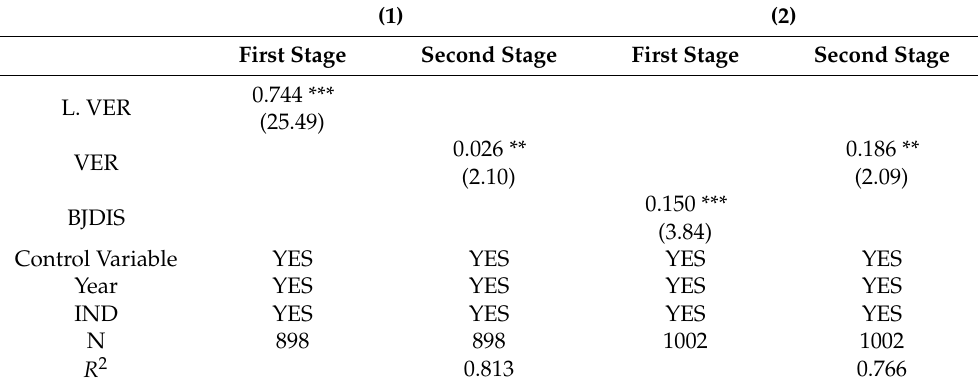
Table 5. Endogenous test